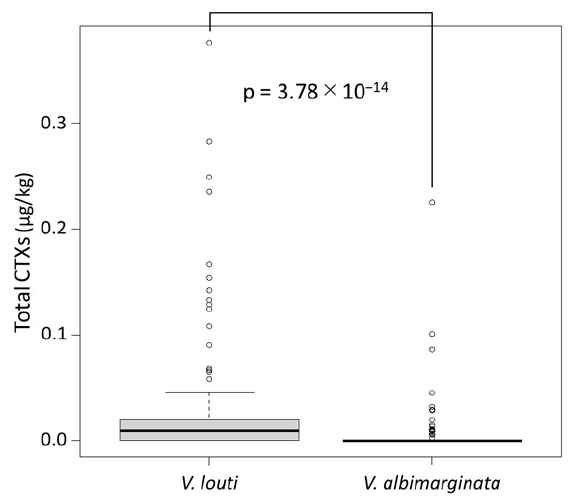
Figure 8. Distribution of total CTX levels in the flesh of V. louti [29] and V. albimarginata captured from Okinawa Islands and Amami Islands, respectively.